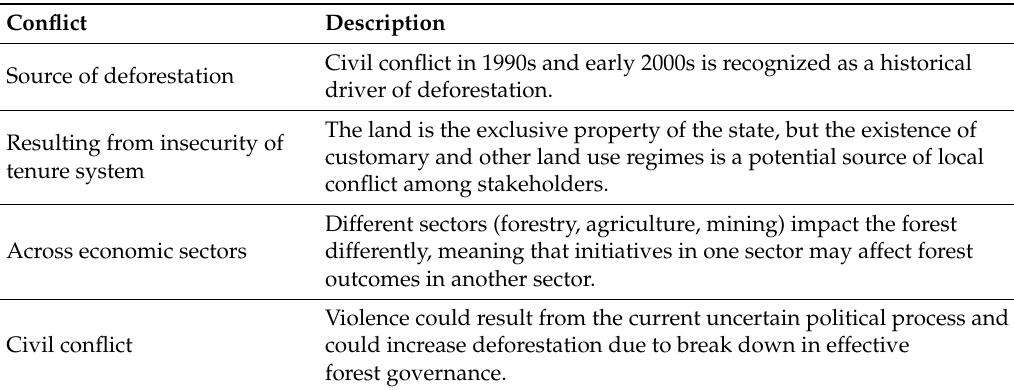
Table 2. Characterization of conflict across the four